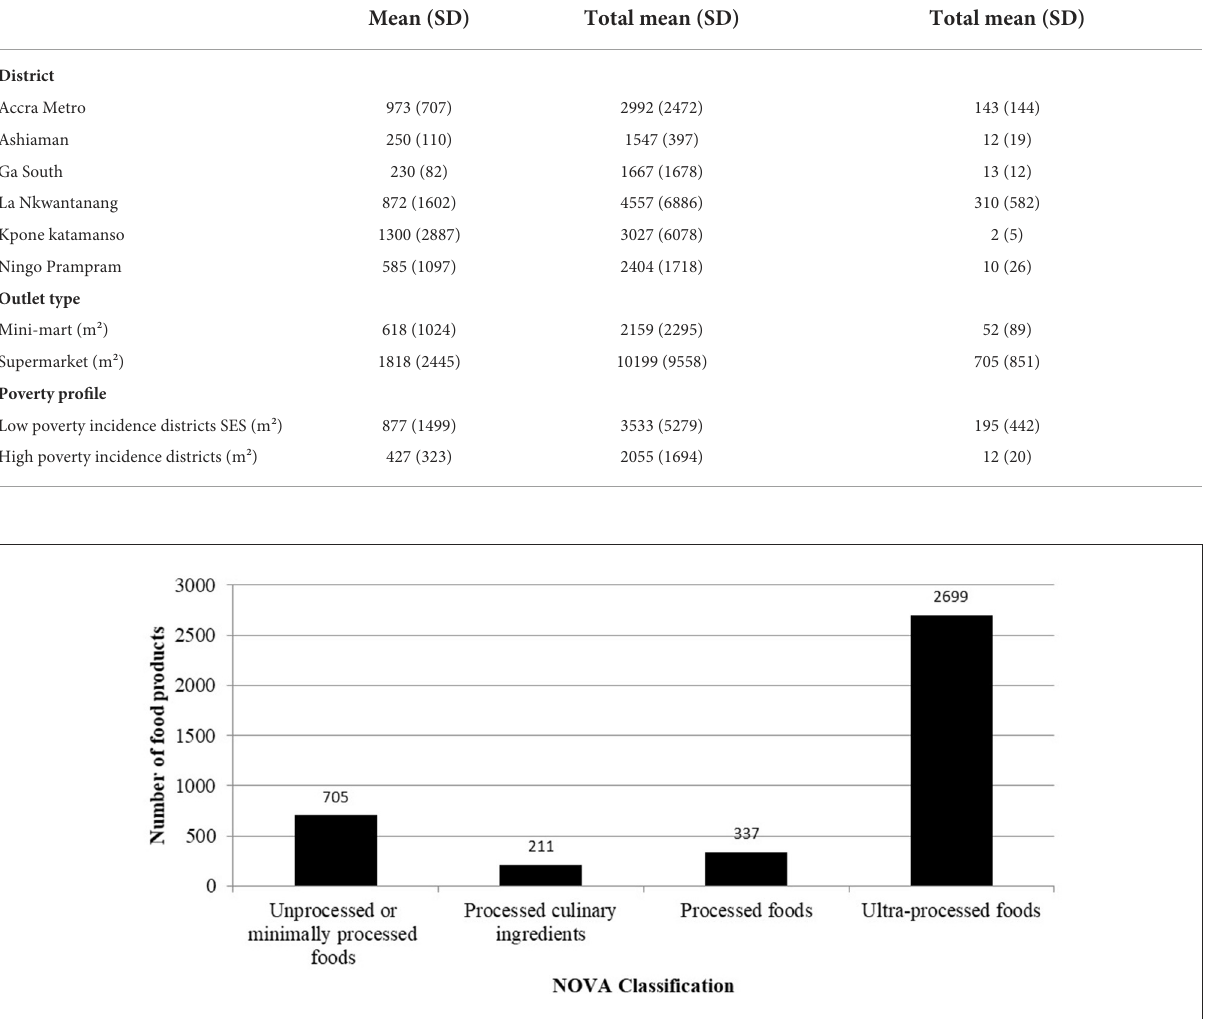
FIGURE3 NOVA classification of unique food products in modern food outlets in all six study